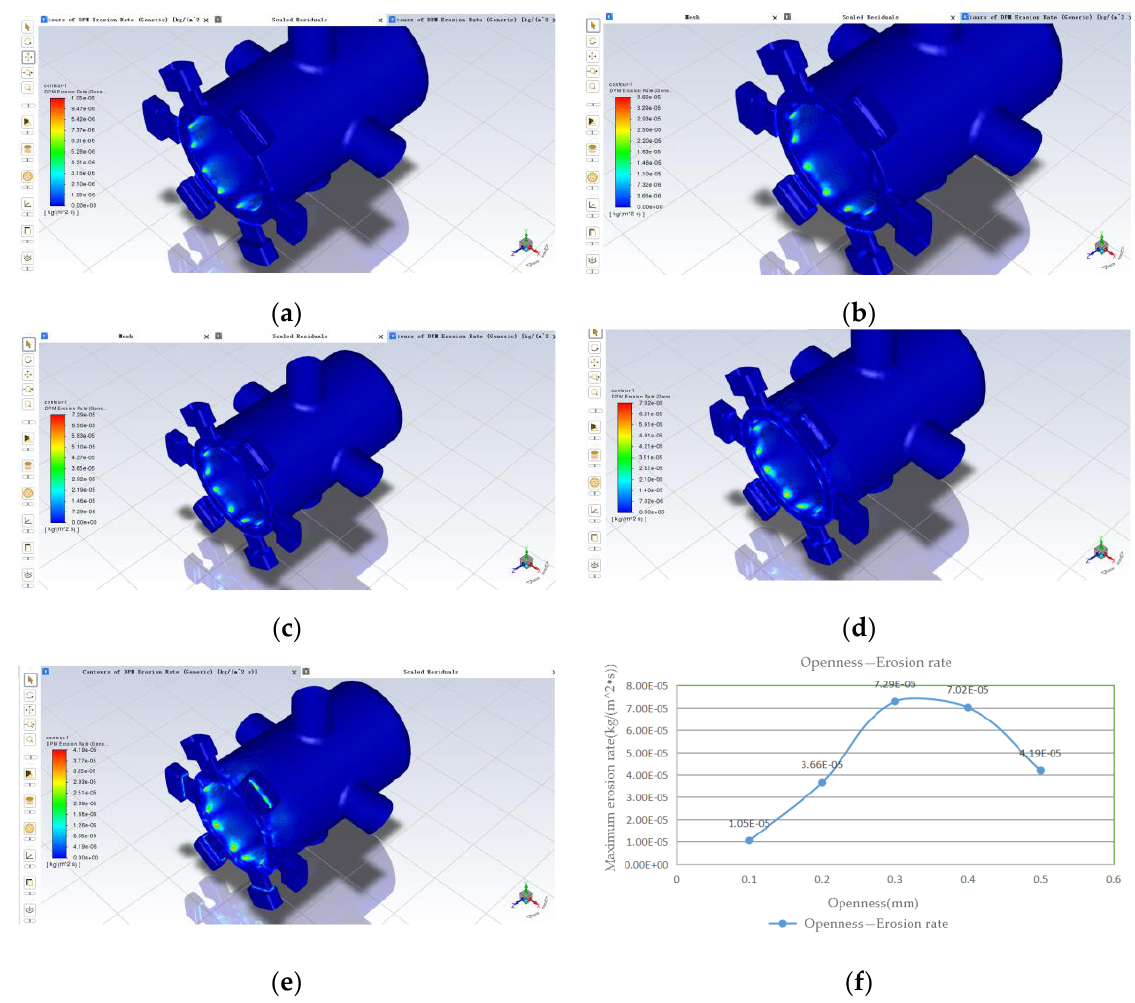
Figure 7. Effect of opening on erosion rate: ( a ) 0.1 mm; ( b ) 0.2 mm; ( c ) 0.3 mm; ( d ) 0.4 mm; ( e ) 0.5 mm; ( f ) variation of maximum erosion rate with increasing opening.